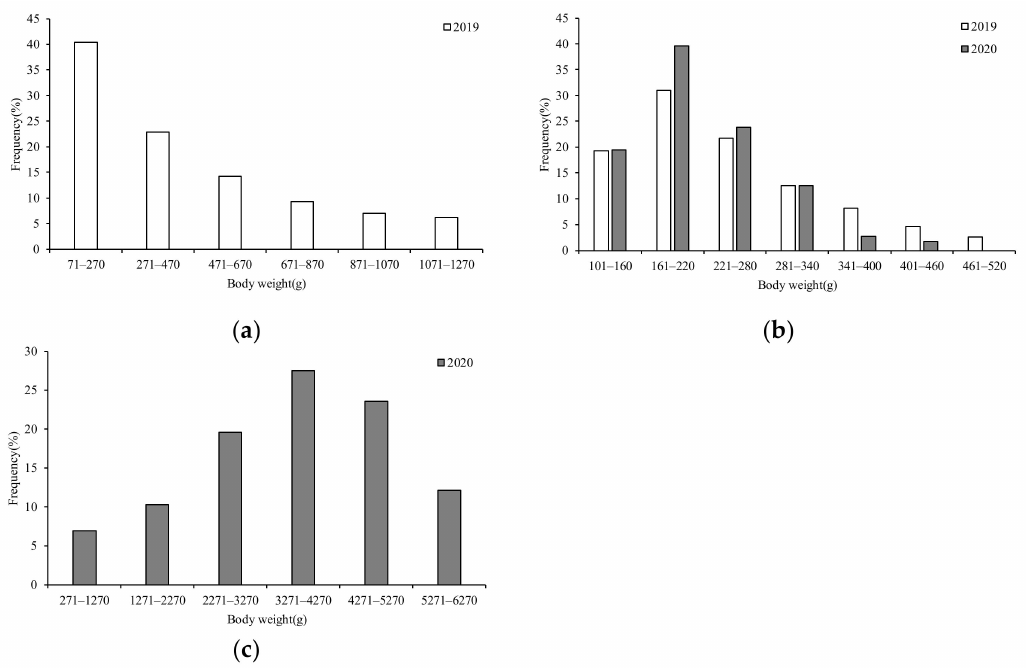
Figure 4. Composition of BW for S. oualaniensis in different years: ( a , c ) female; ( b )